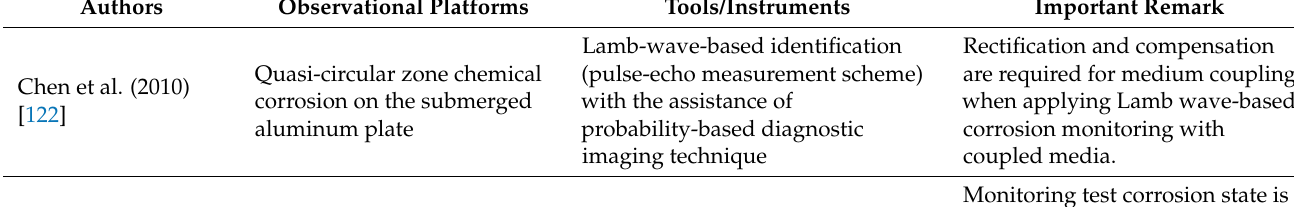
Table 10. Landmark research on the sensor technology applications for monitoring corrosion in various marine structures.